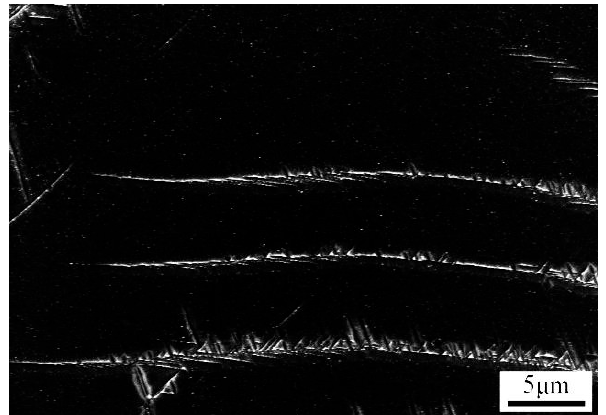
Figure 6. SEM micrograph of Ti–3.5Al–5Mo–4V alloy isothermally aged at 500 °C for 45 min after being solution-treated at 850 °C.